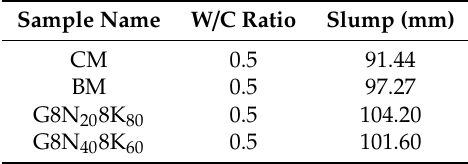
Table 7. Slump value of concrete samples. CM: control mixture of cement; BM: control bagasse ash mixture.